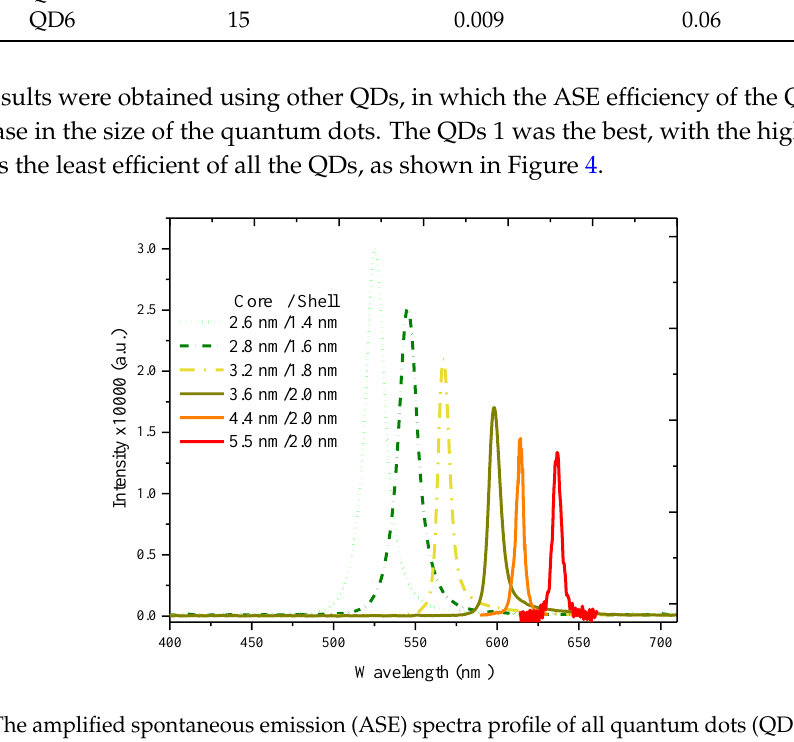
Figure 4. The amplified spontaneous emission (ASE) spectra profile of all quantum dots (QD 1 to QD 6) for a concentration ranging between 20 and 30 mg in 5 mL THF.